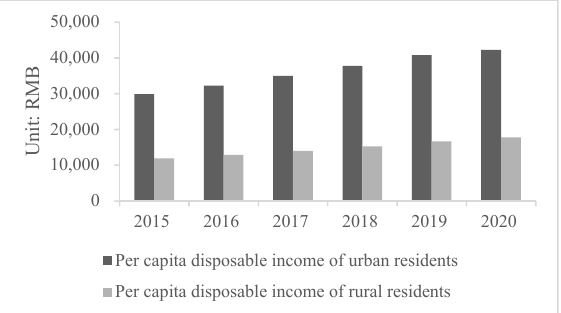
Figure 1. Chinese urban and rural resident per capita disposable income from 2015 to 2020 (Data source: National Bureau of Statistics of China).